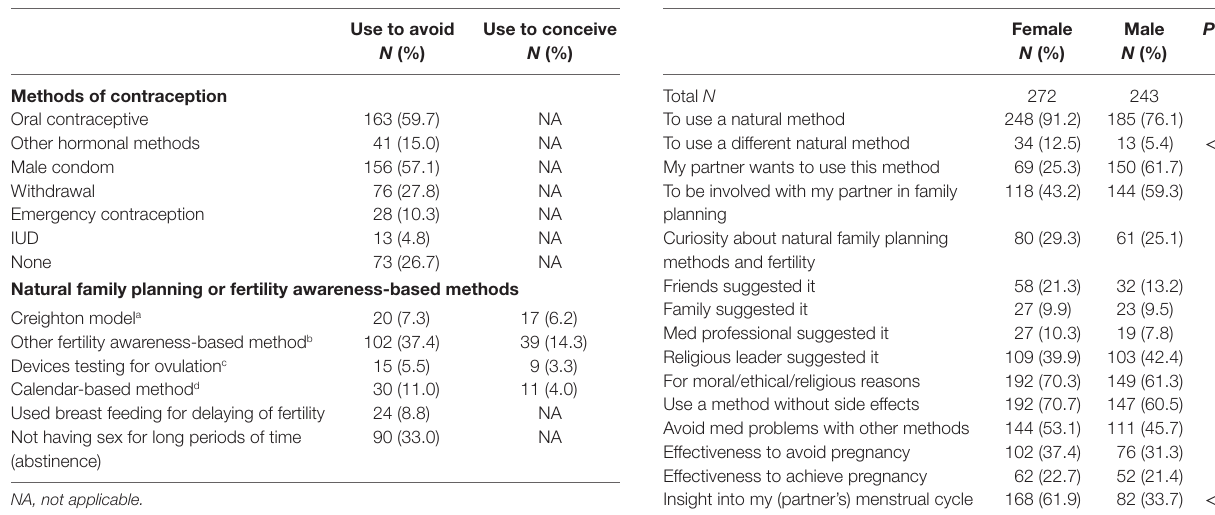
TaBle 4 | Women’s and men’s reasons for choosing to learn the Creighton Model Fertility Care TM